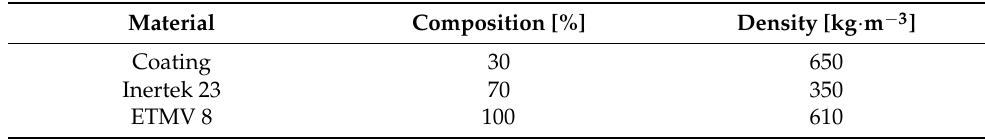
Figure 3. View of the ETMV8 Sample-gypsum board used for experimental tests.